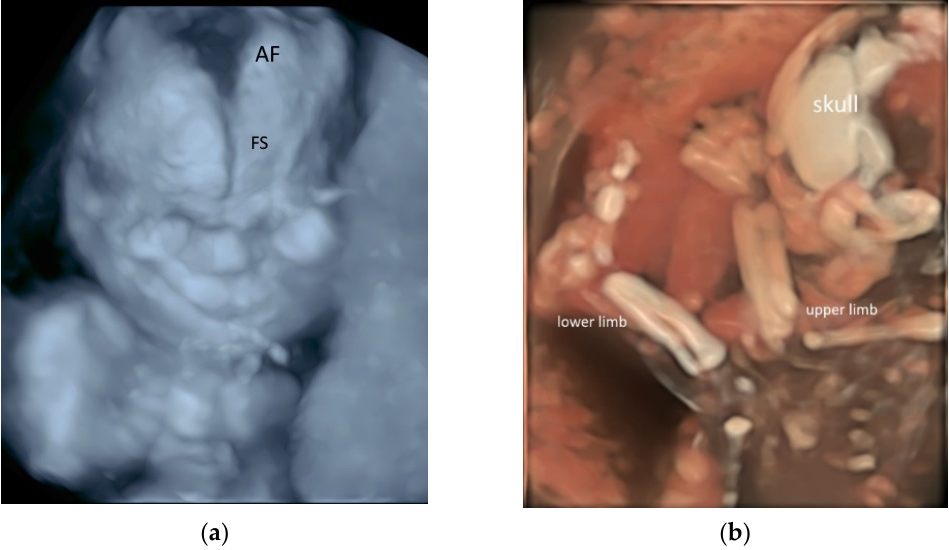
Figure 11. Three-dimensional rendered images of the fetal skeleton at 20–22 weeks’ gestation showing: ( a ) X-ray mode of the skull bone with frontal suture (SS) and anterior fontanelle (AF), and ( b ) HD skeletal mode of the skull, bones of the upper and lower